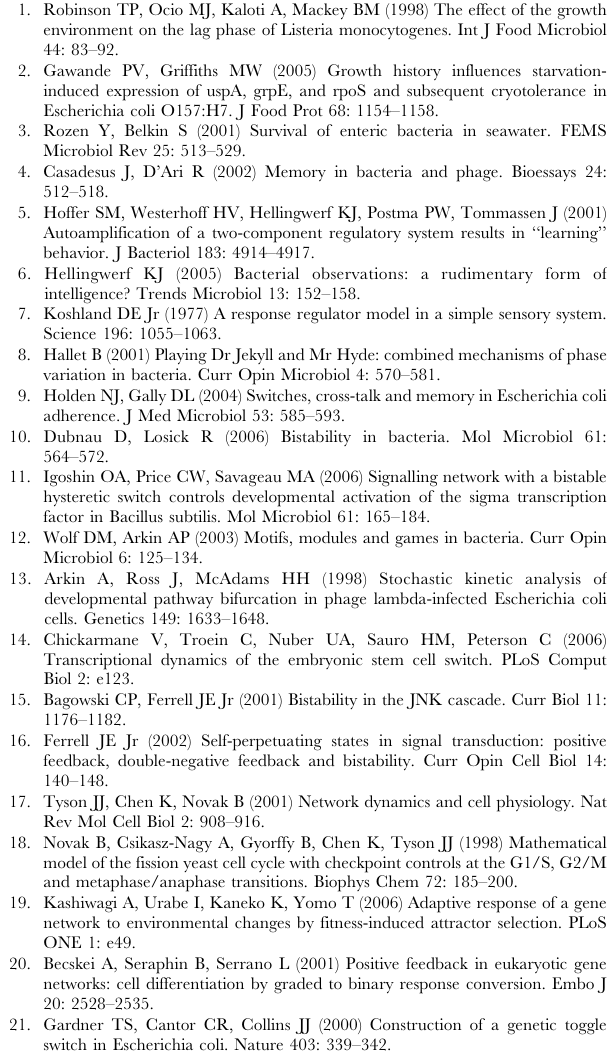
Figure S1 Example histograms from flow cytometry analysis of B. subtilis strain KEE.